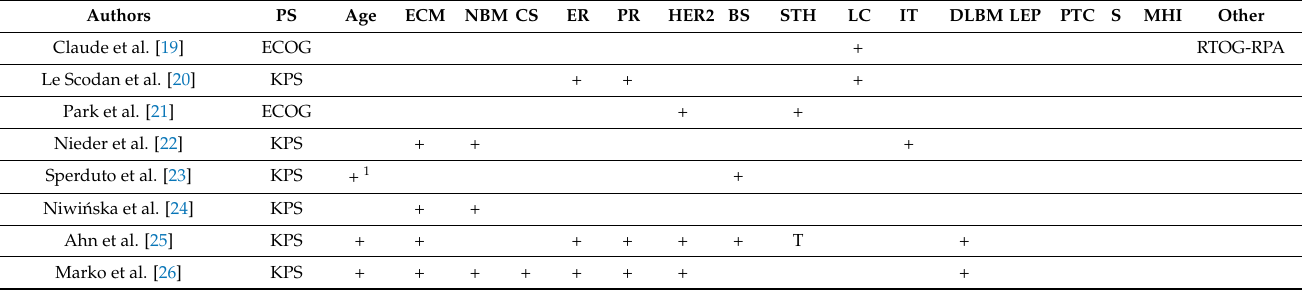
Table 3. Factors related to OS in prognostic tools, in BC patients with brain metastases published from 1997 to